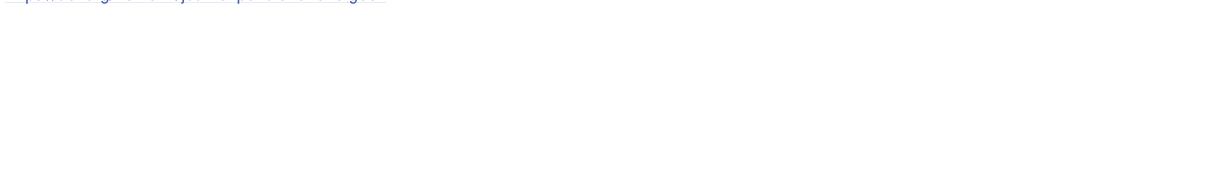
PLOS ONE | https://doi.org/10.1371/journal.pone.0234628 June 16,